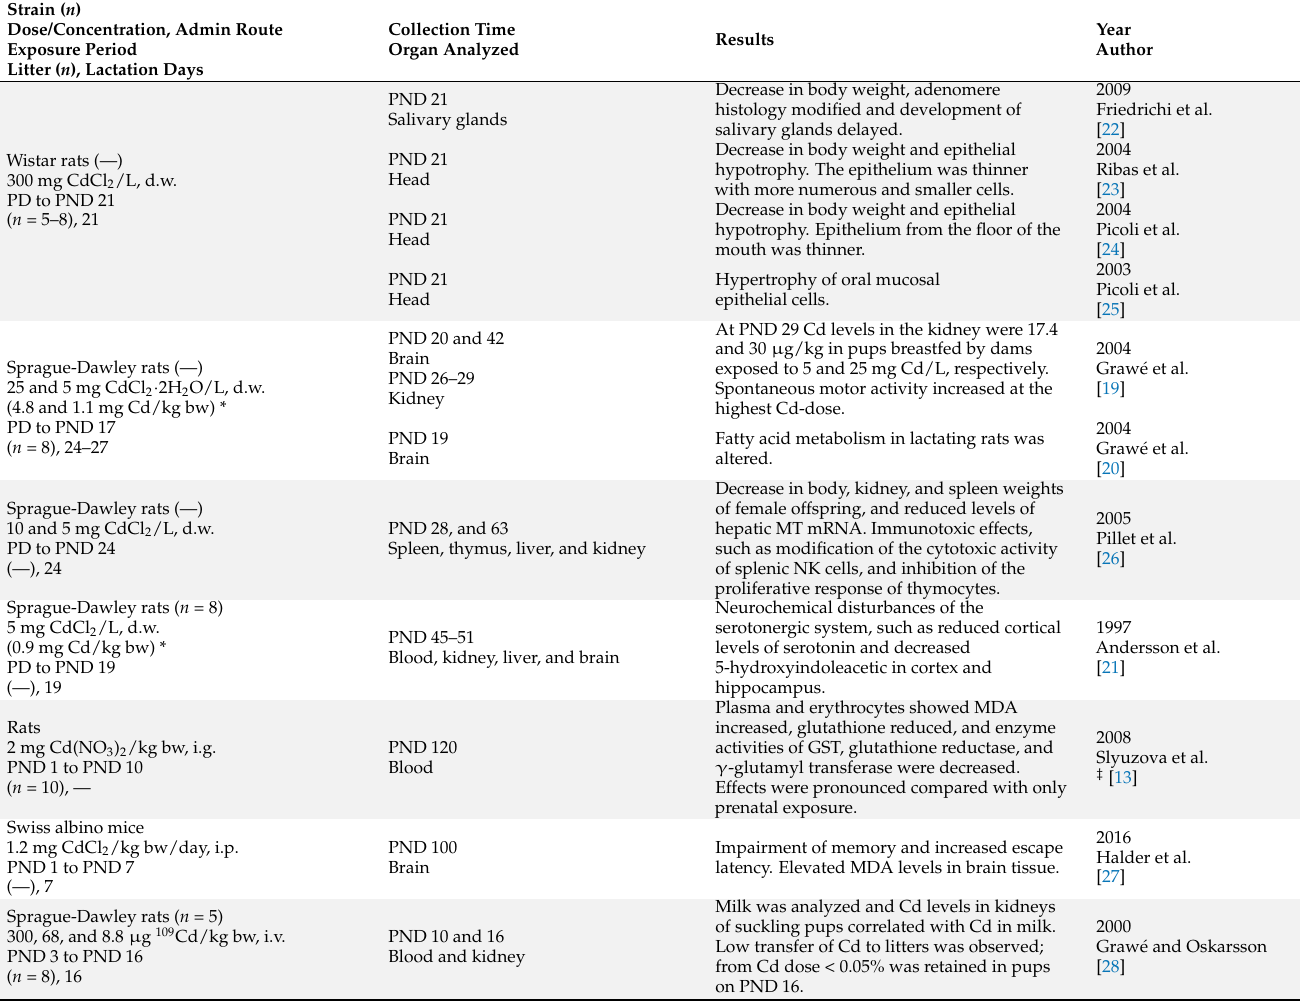
Table 2. Cd exposure during lactation period. Data ordered by dose/concentration of Cd adminis- tered to